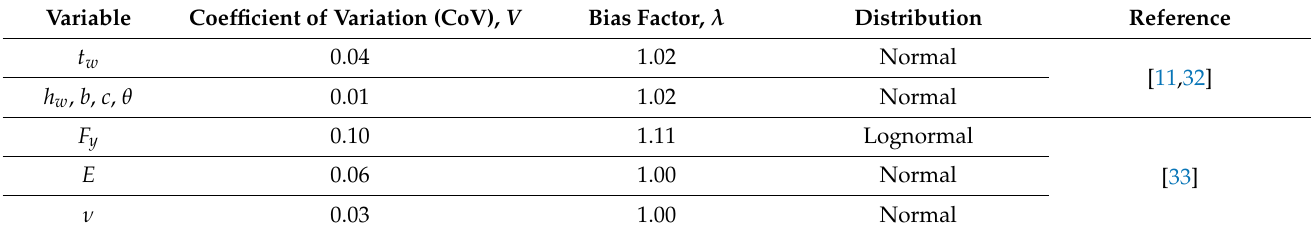
Table 3. Statistical parameters for the geometric and material variables involved in the model.